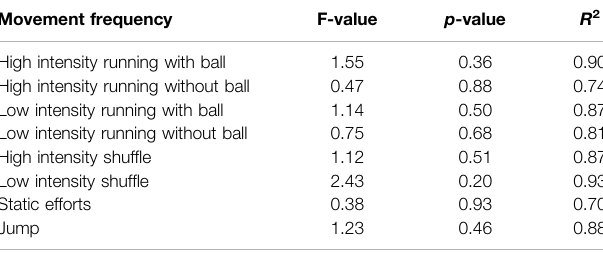
TABLE 5 | Prediction of the various movements classes from metabolites using regression analysis in frontcourt players. Movement frequency F-value p -value R 2 High intensity running with